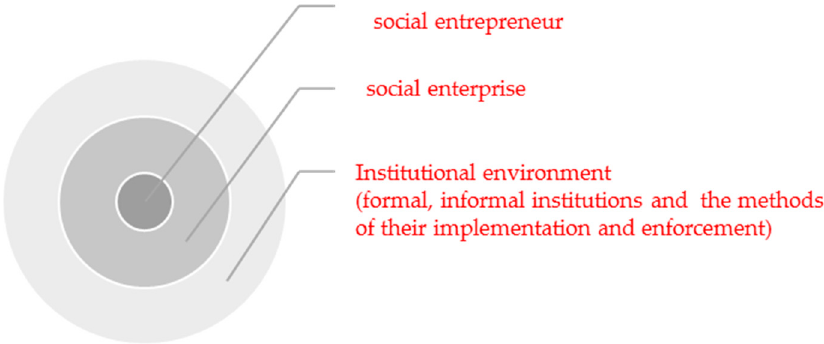
Figure 1. Institutional framework of social enterprise. Source: Own study.